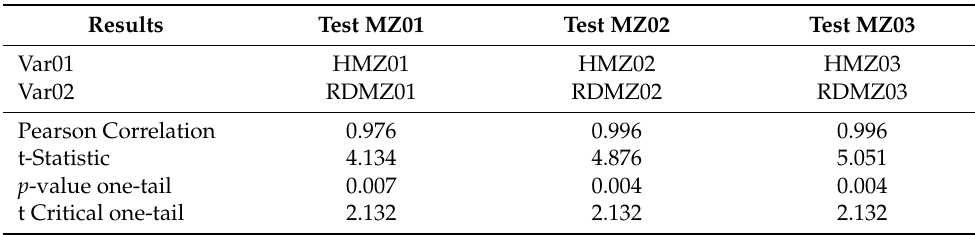
Table 2. Result of the statistical significance tests of the correlation between the average of RD and H per MZ over the 2020 growing season.